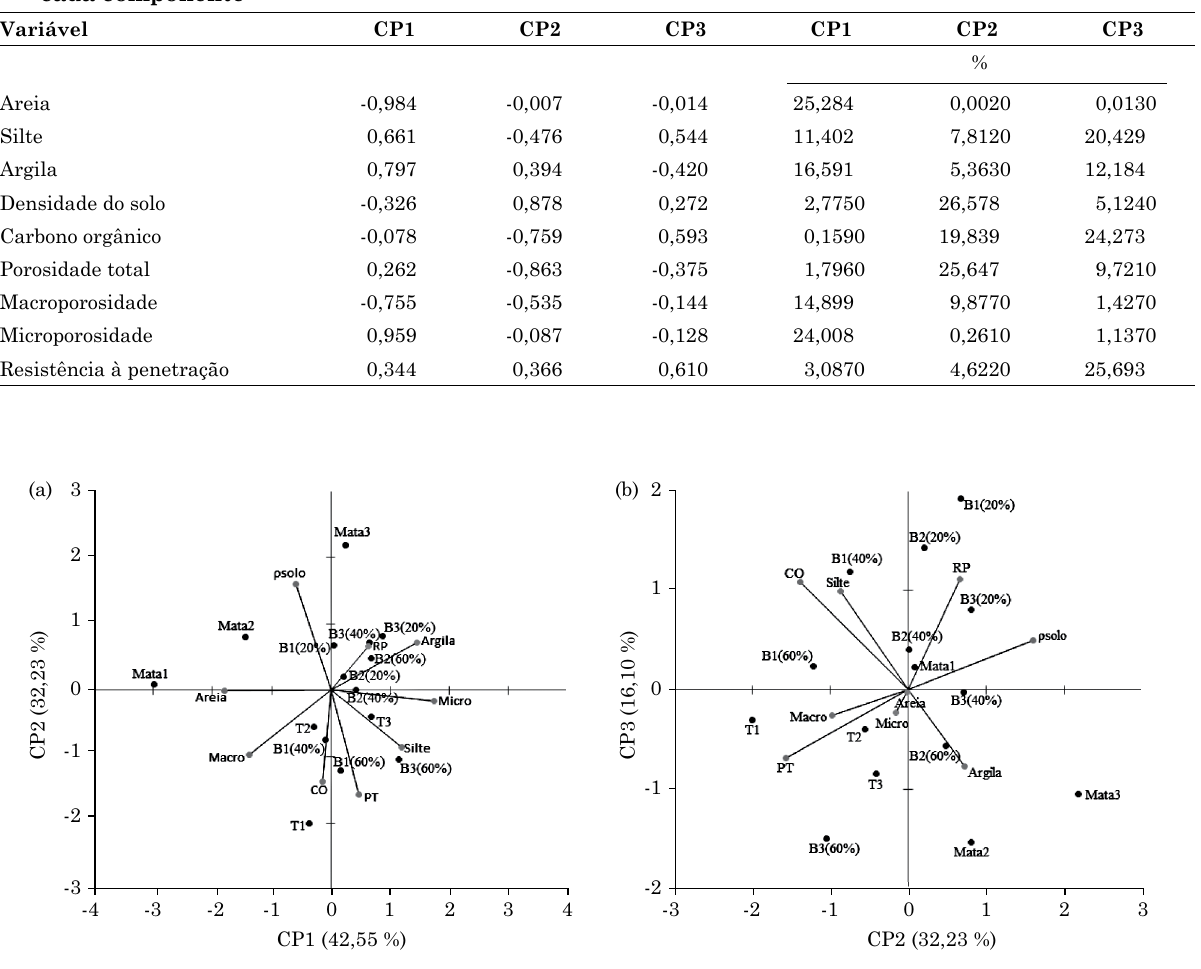
Na figura 9b, que trata dos componentes principais 2 e 3, observa-se que as variáveis densidade do solo e macroporosidade apresentaram